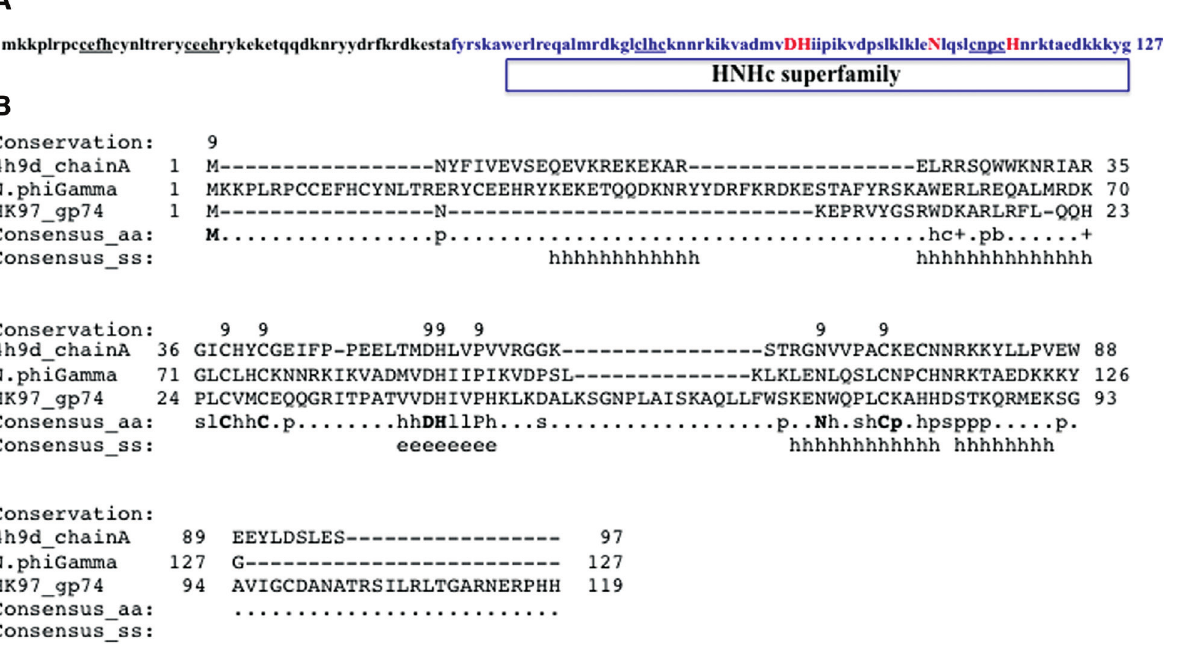
Figure 3: The aa sequence alignment of N. φ Gamma and gp74 of phage HK97. (A) Schematic output of BlastP analysis using N. φ Gamma aa sequence as a query. The conserved HNH nuclease domain is shown in a blue box where the ββα -metal motif is located. (B) The aa sequence alignment of Gme_HNHE, N. φ Gamma, and HK97_gp74 by web